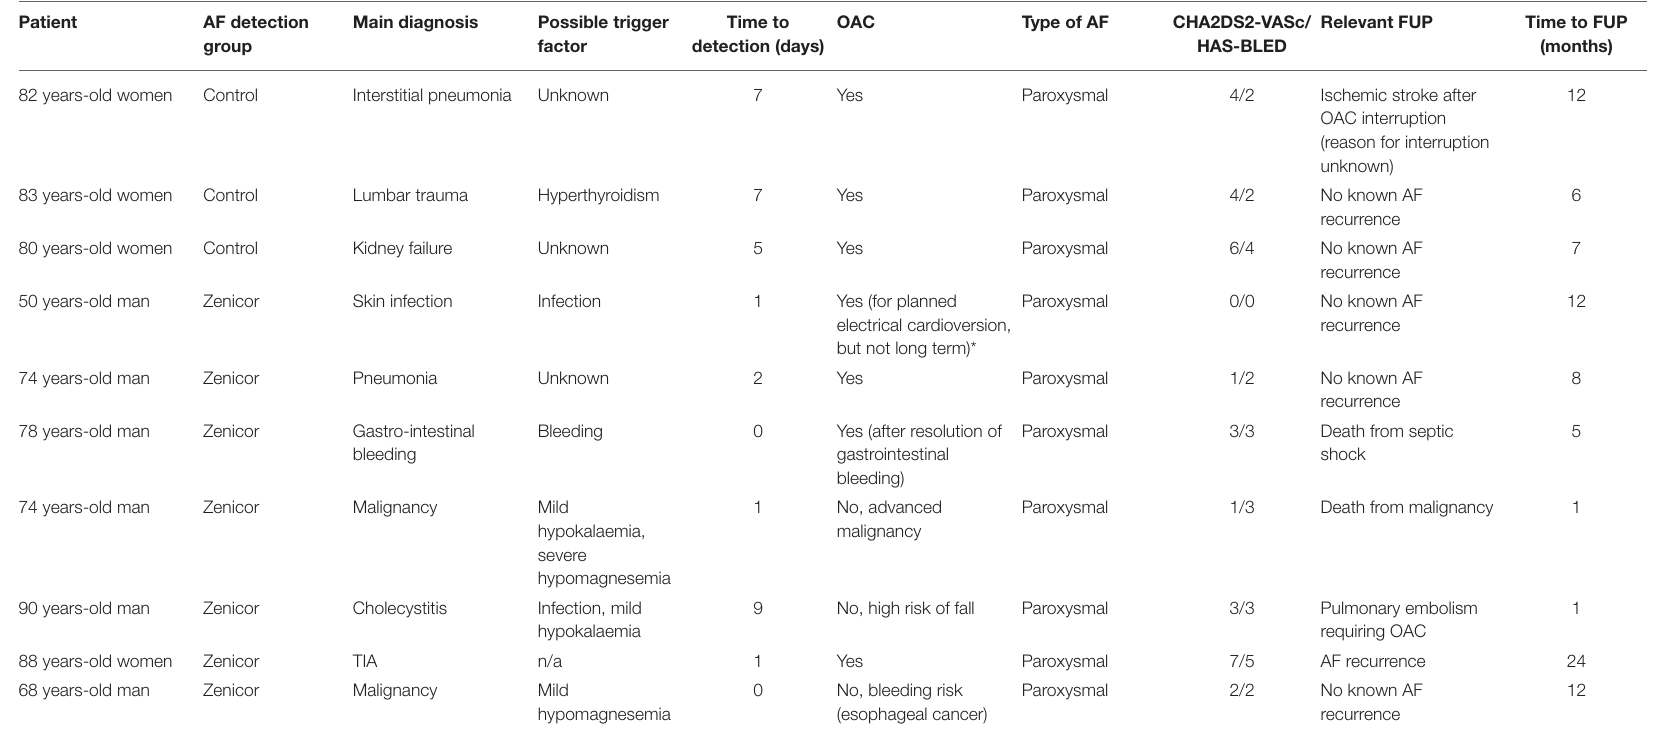
TABLE 3 | Clinical characteristics of patients with newly detected atrial